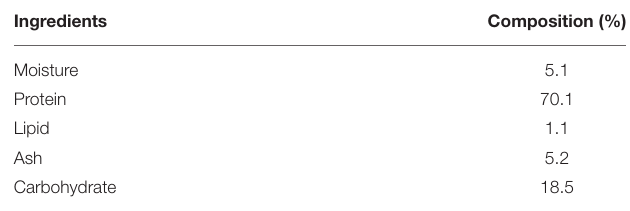
TABLE 1 | The composition of